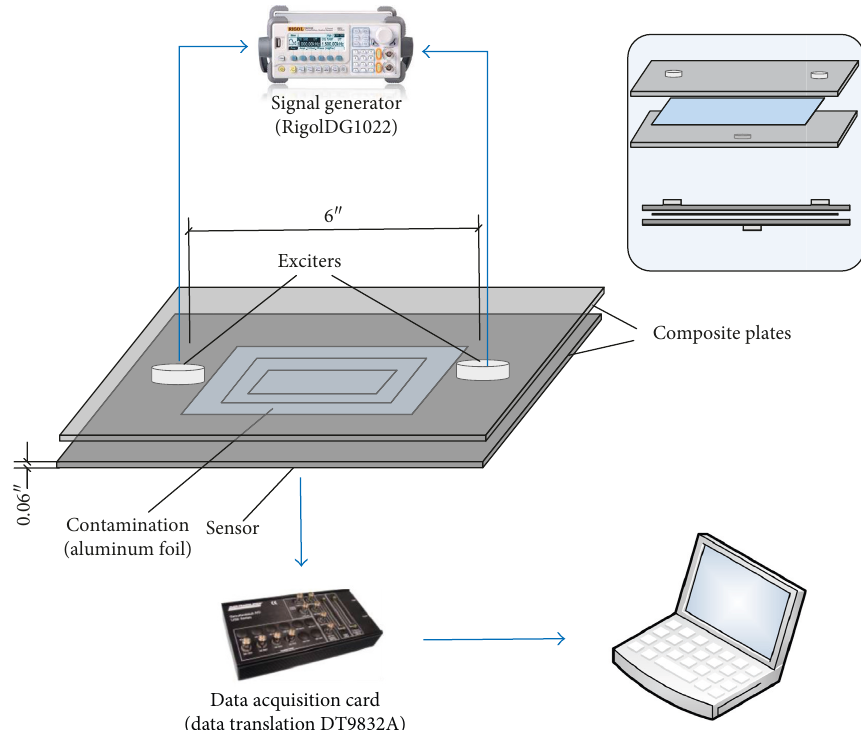
Figure 1: Diagram of the bond inspection setup to evaluate the performance of the heterodyne effect.